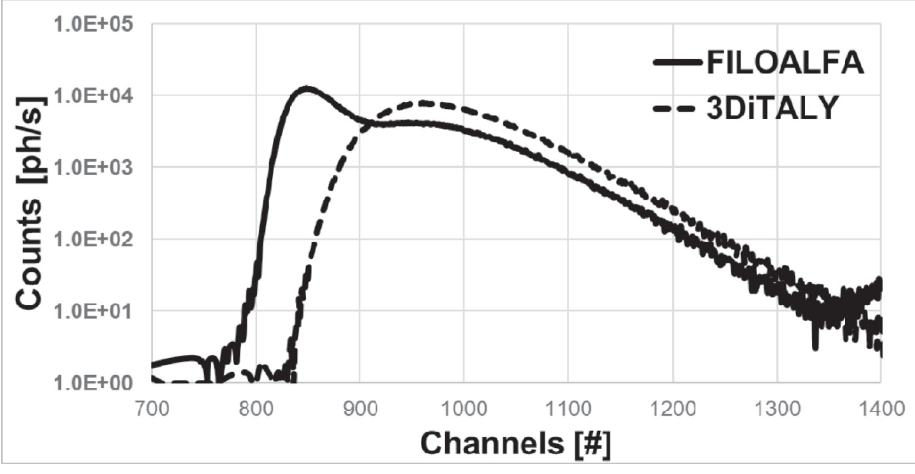
Fig 9. DTOFs acquired on the calibration phantom with two probes printed with different PLA filaments. Dashed line: 3DiTALY filament; solid line: FILOALFA filament. On the x-axis, the channels are the time bins of the time- correlated single-photon counting board used for the acquisitions: Each channel corresponds to 8 ps.